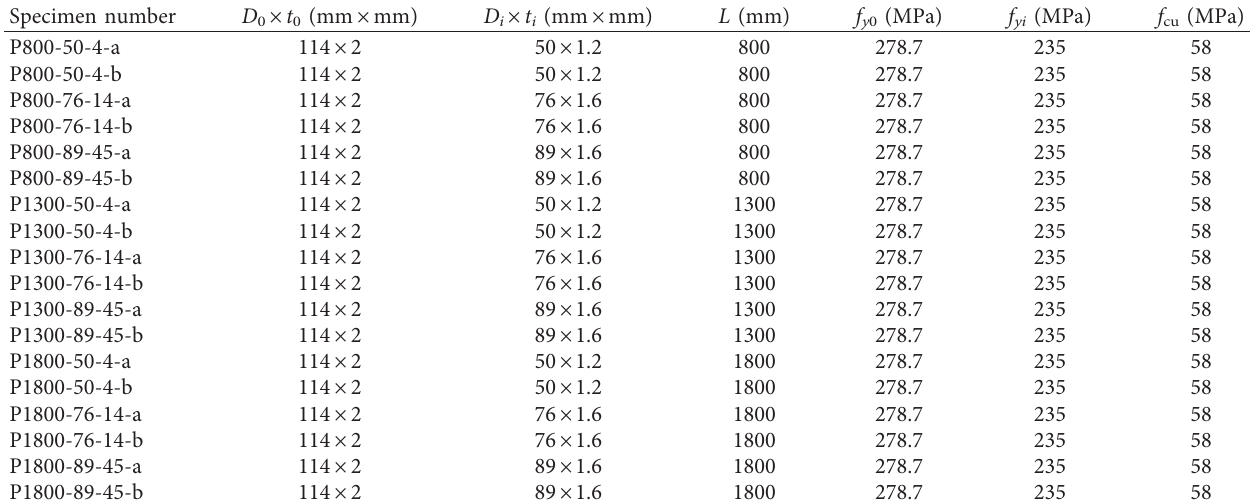
Table 2: Size and strength of eccentric compression specimens.